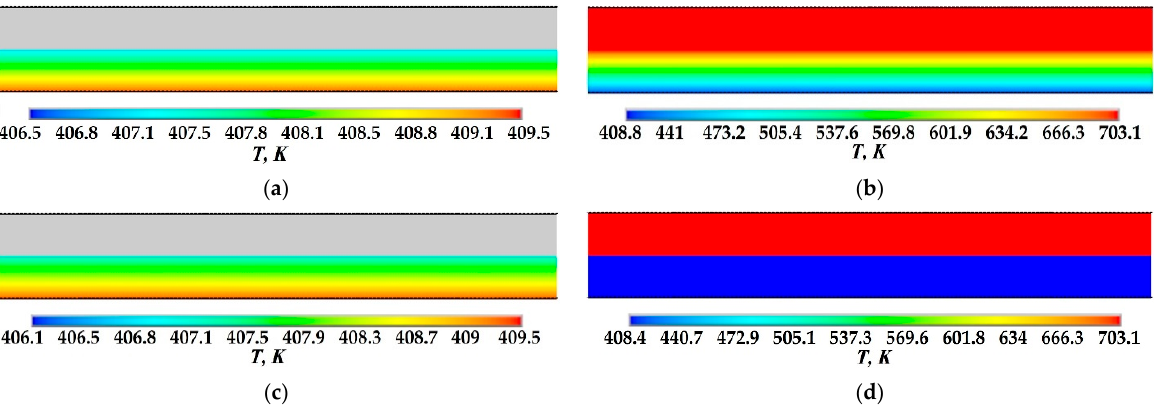
Figure 21. Demonstration of the refiring of the mechanism of energy supply to the system: ( a , b )—the time of the end of the cooling of the first layer and the instantaneous heating of the second layer of plate material, respectively, before correction; ( c , d )—the same, after correction.